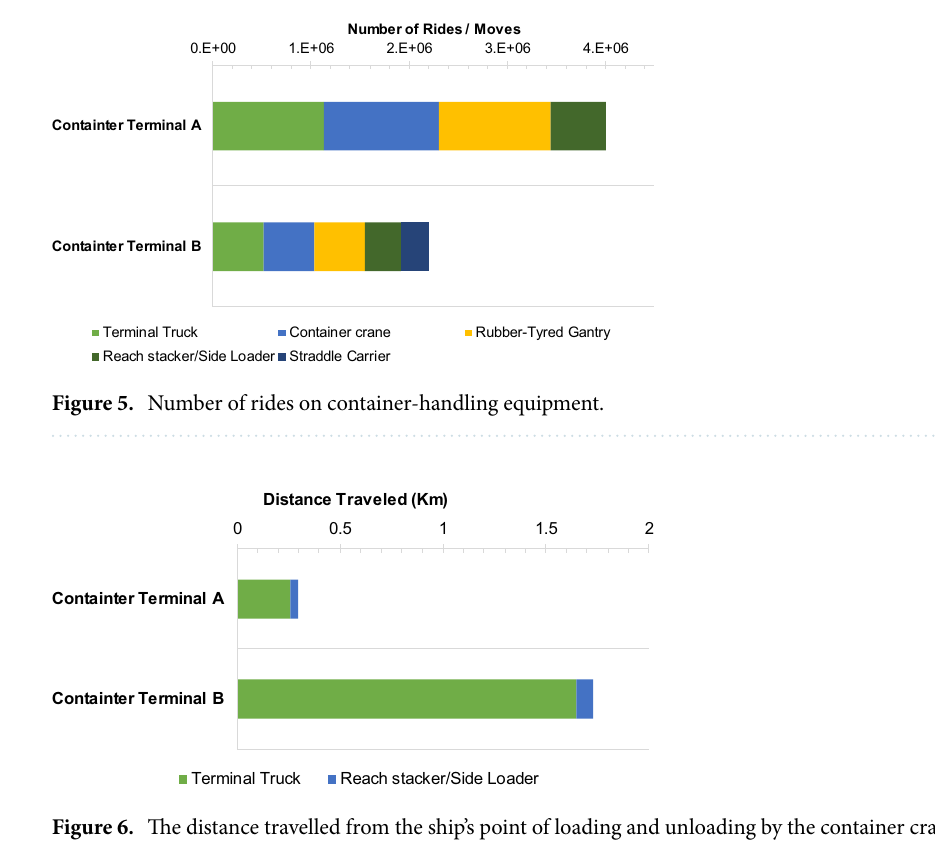
Figure 6. The distance travelled from the ship’s point of loading and unloading by the container crane to the stacking yard.